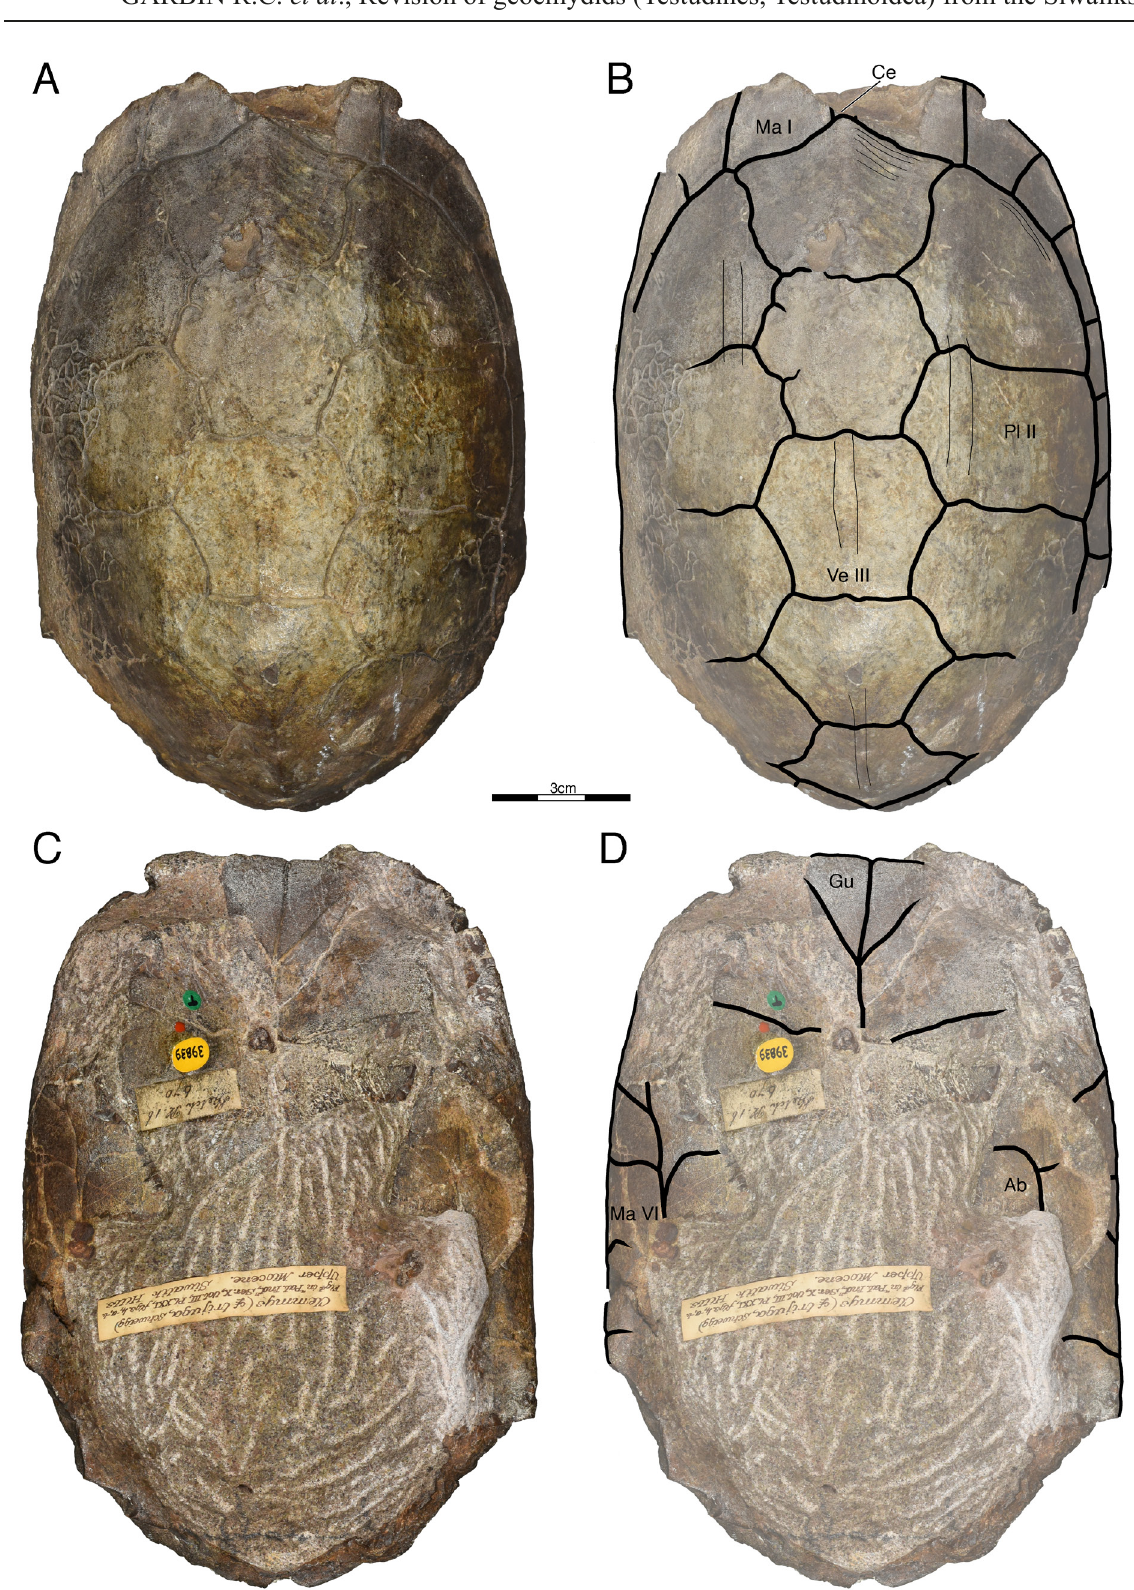
Fig. 32. BMNH 39839, holotype of Nicoria tricarinata var. sivalensis Lydekker, 1889, here identified as Melanochelys tapani nom. nov. A . Photograph of carapace. B . Illustration of carapace. C . Photograph of plastron. D . Illustration of plastron. Scale bar: